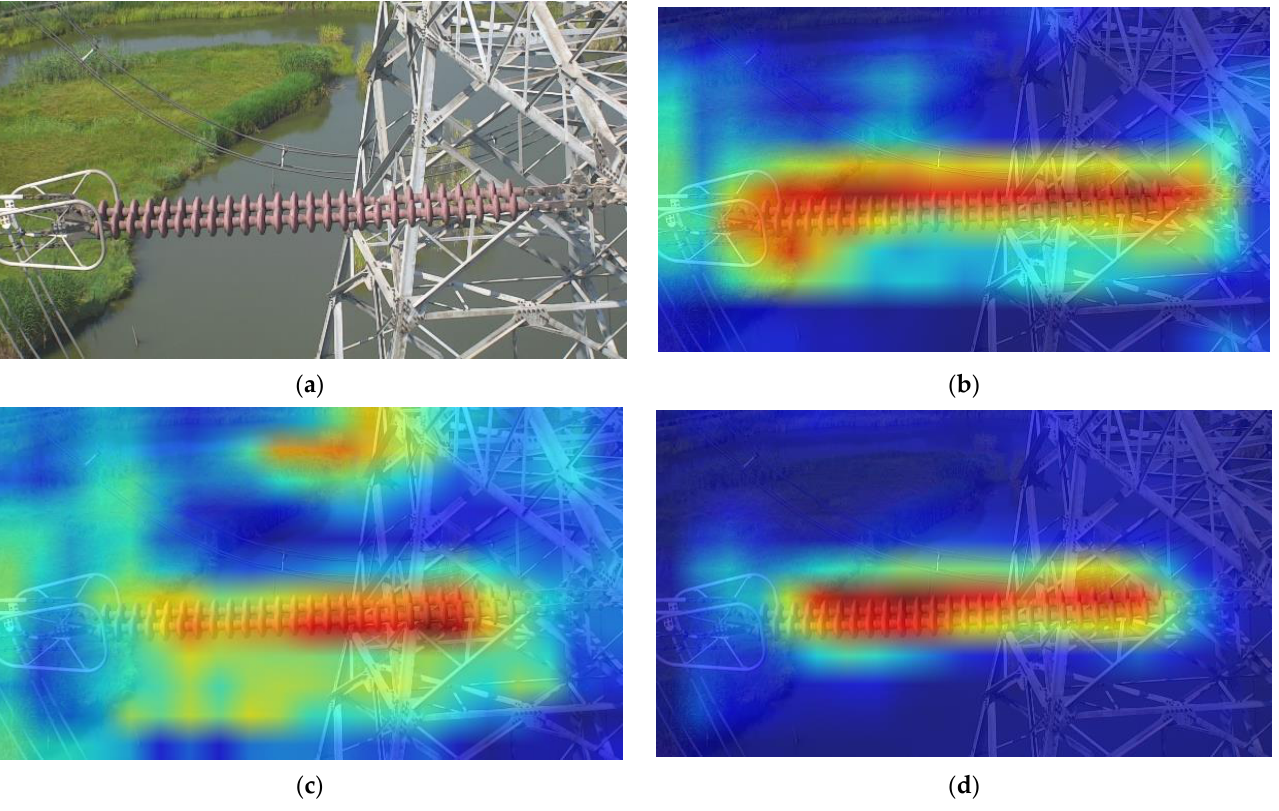
Figure 14. Heat maps for different attention modules: ( a ) original image; ( b ) SE; ( c ) CBAM; ( d ) CA.